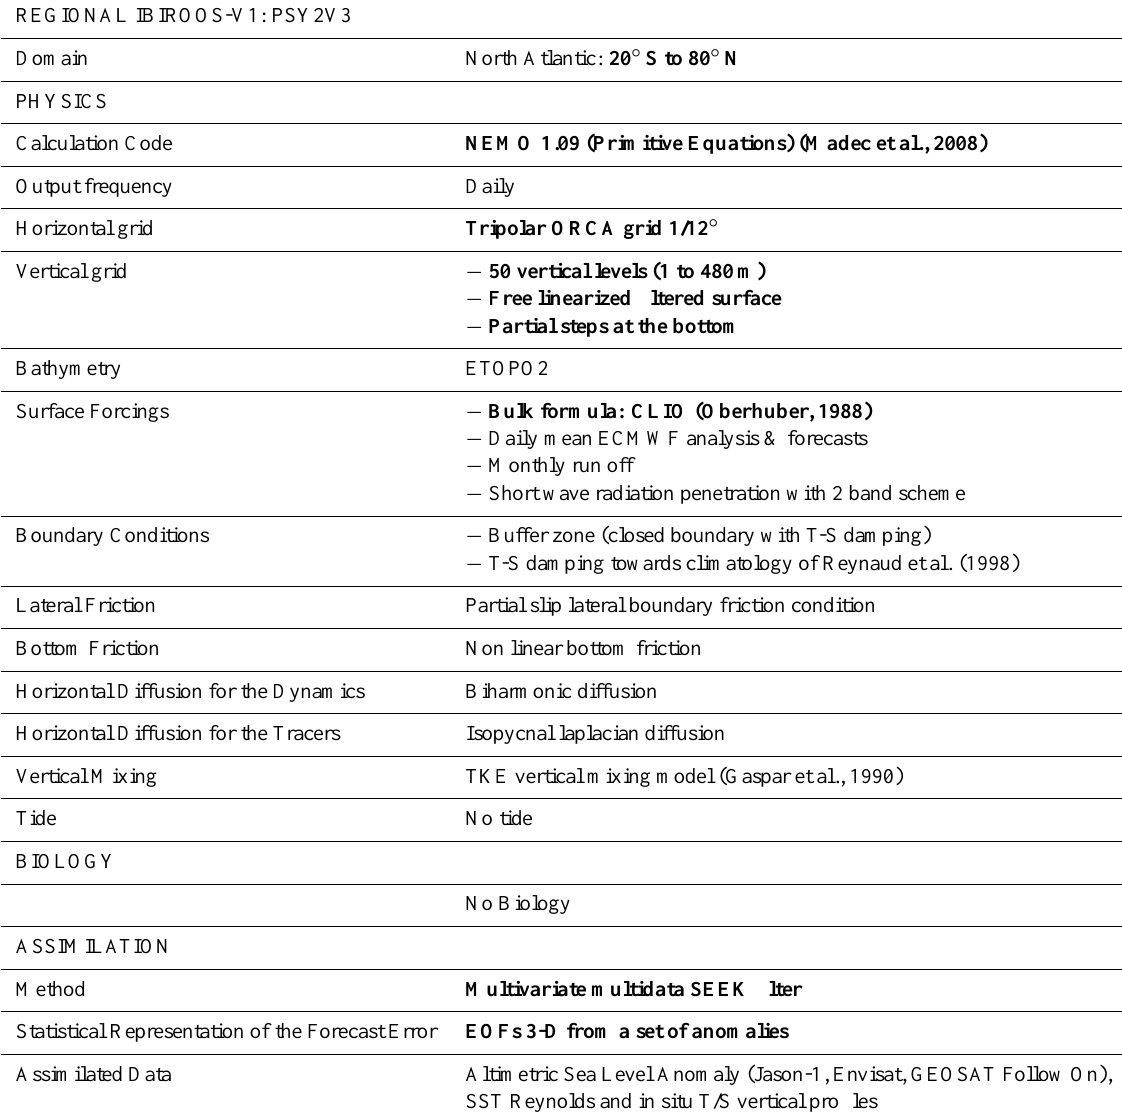
Table 2. Description of regional IBIROOS-V1: PSY2V3. Differences between V1 and V0 versions are written in bold characters. REGIONAL IBIROOS-V1: